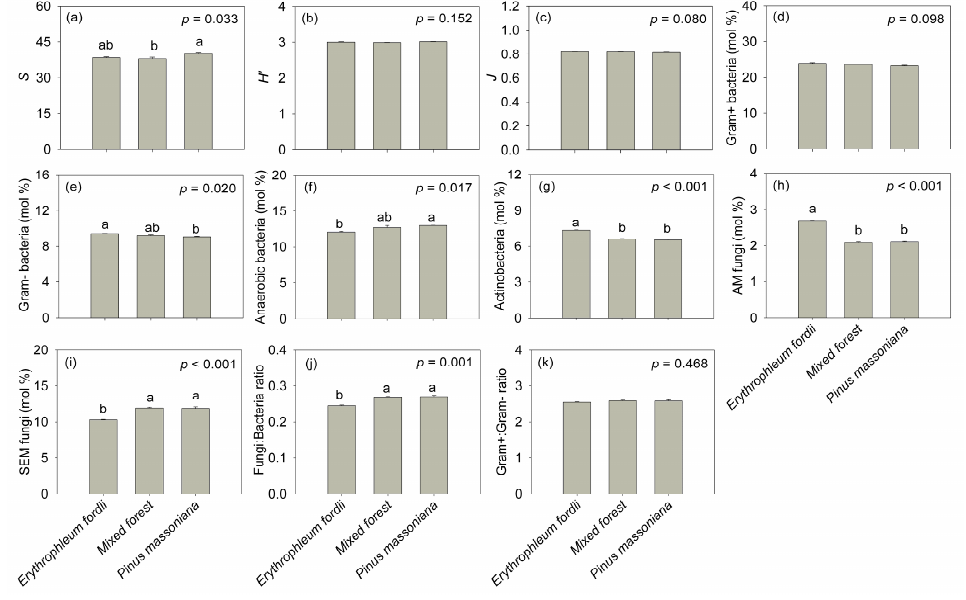
Figure 6. Soil microbial community attributes determined from three subtropical plantation soils in China. S : species richness index; H’ : Shannon’s diversity index; J : Pielou’s evenness index; AM fungi: arbuscular mycorrhizal fungi; SEM fungi: saprotrophic and ectomycorrhizal fungi. Different letters indicate statistically significant differences among plantation types. Error bars represent the standard error of the mean ( n = 3).